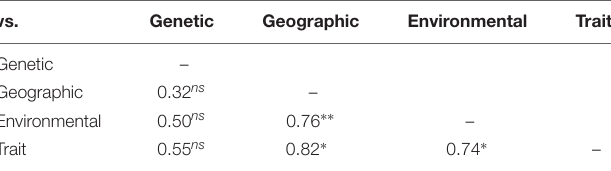
TABLE 1 | Summary of Mantel correlation coefficients between the studied seed trait (endosperm to coat proportion) and environmental, genetic, and geographic distance matrices among